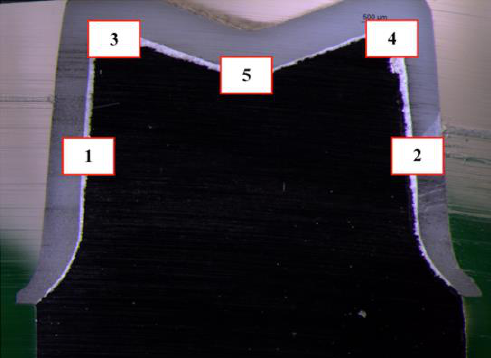
Figure 3. Five areas selected for the measurements using a Stereoscopic Microscope at 1.6× magnification.